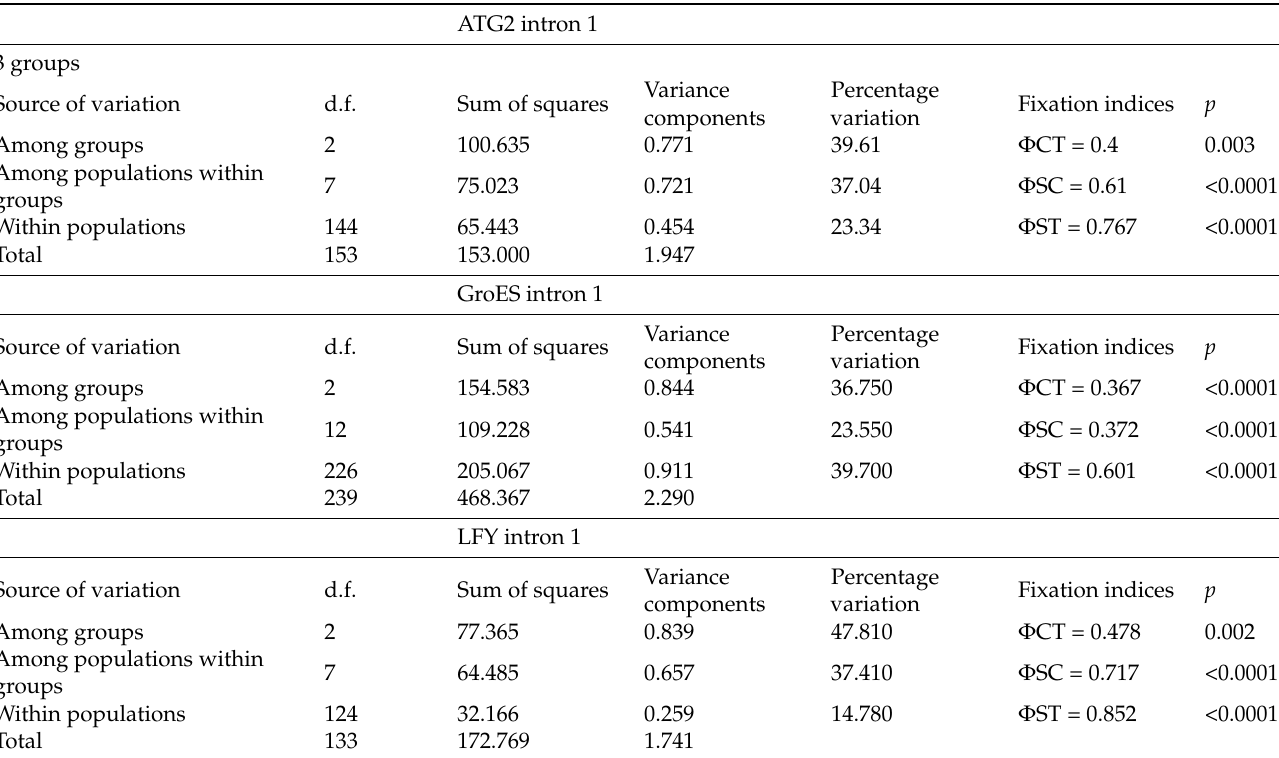
Table 4. Hierarchical analysis of molecular variance (AMOVA) in Conandron obtained from sequences of three